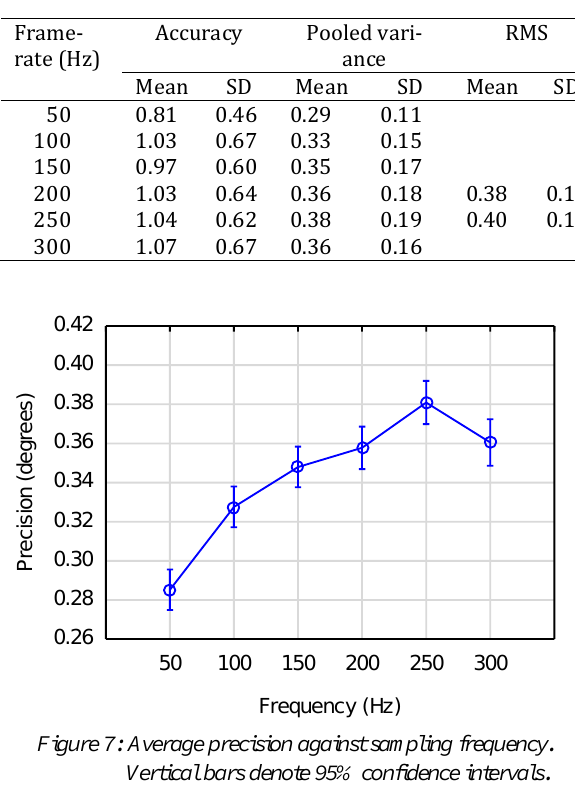
Table 3. Precision as affected by head position